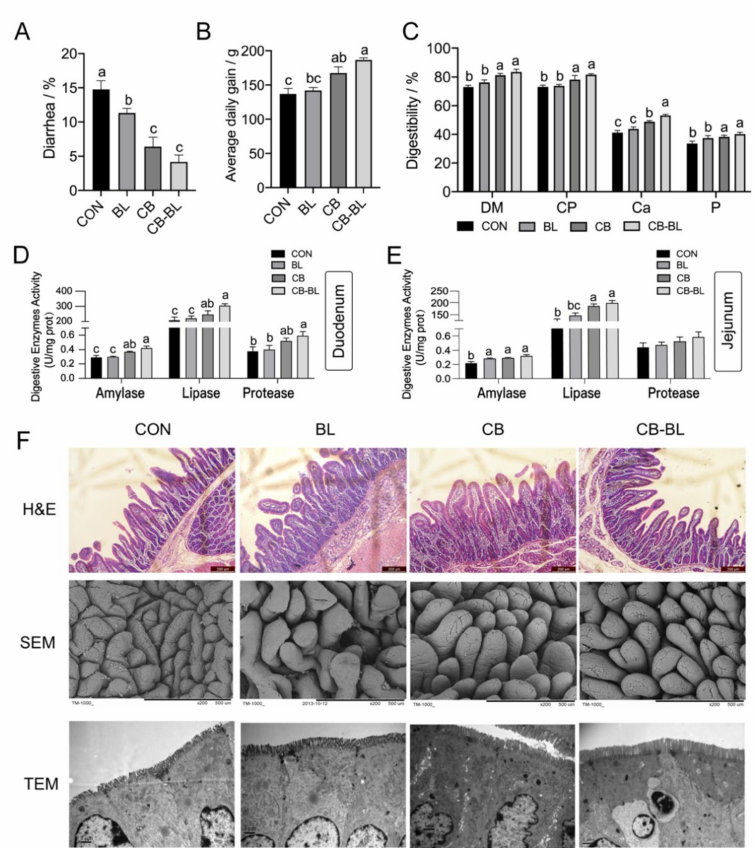
Figure 1. Effects of C. butyricum ZJU-F1 on diarrhea rate, nutrients digestibility, digestive enzymes activity, and intestinal morphology. ( A – C ) The diarrhea rate ( A ), average daily gain ( B ), nutrients digestibility ( C ), and digestive enzymes activity of duodenum and jejunum ( D – E ) of piglets fed each diet. The data are expressed as the mean ± SEM; bars with different small capital letters are statistically different from one another. n = 30 (A–B), n = 6 (C–E) biological replicates. ( F ) Intestinal morphology of duodenum sections. Representative H&E-stained section from duodenum (top; bars, 200 µ m), SEM images (middle; bars, 500 µ m), TEM images (bottom; bars, 1 µ